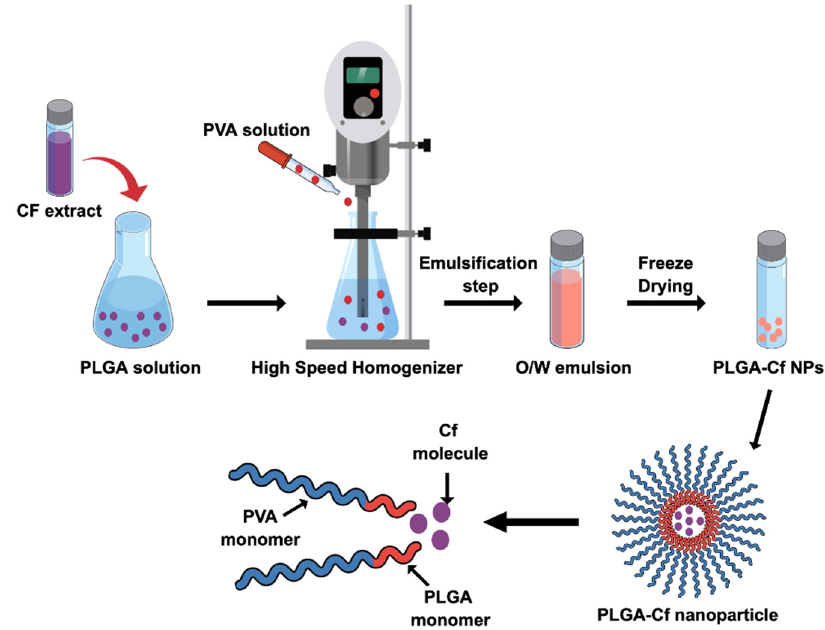
Figure 1. Schematic representation for PLGA-Cf NPs synthesis. Table 2. Experimental matrix and observed responses from randomized runs in BBD.